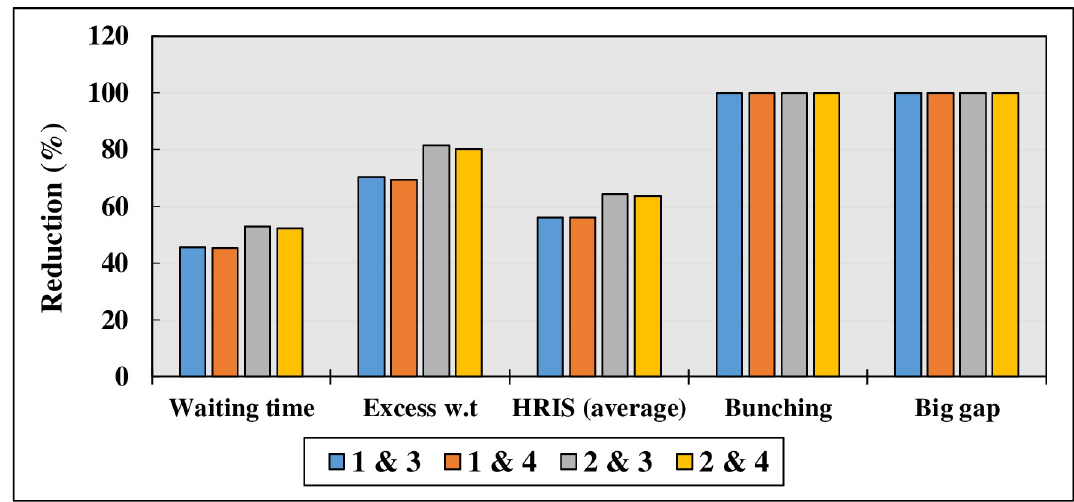
Fig 9. Comparison of combination of